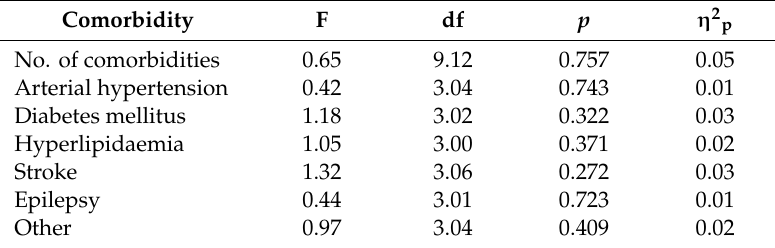
Table 2. Serum copper concentration versus